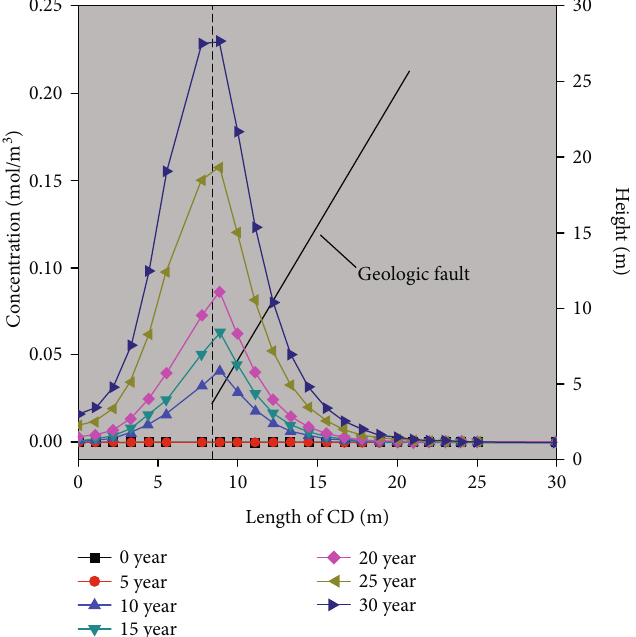
Figure 12: The contaminant concentration along the line of CD in the MFF model. Table 2: The fault length in the di ff erent models. Model